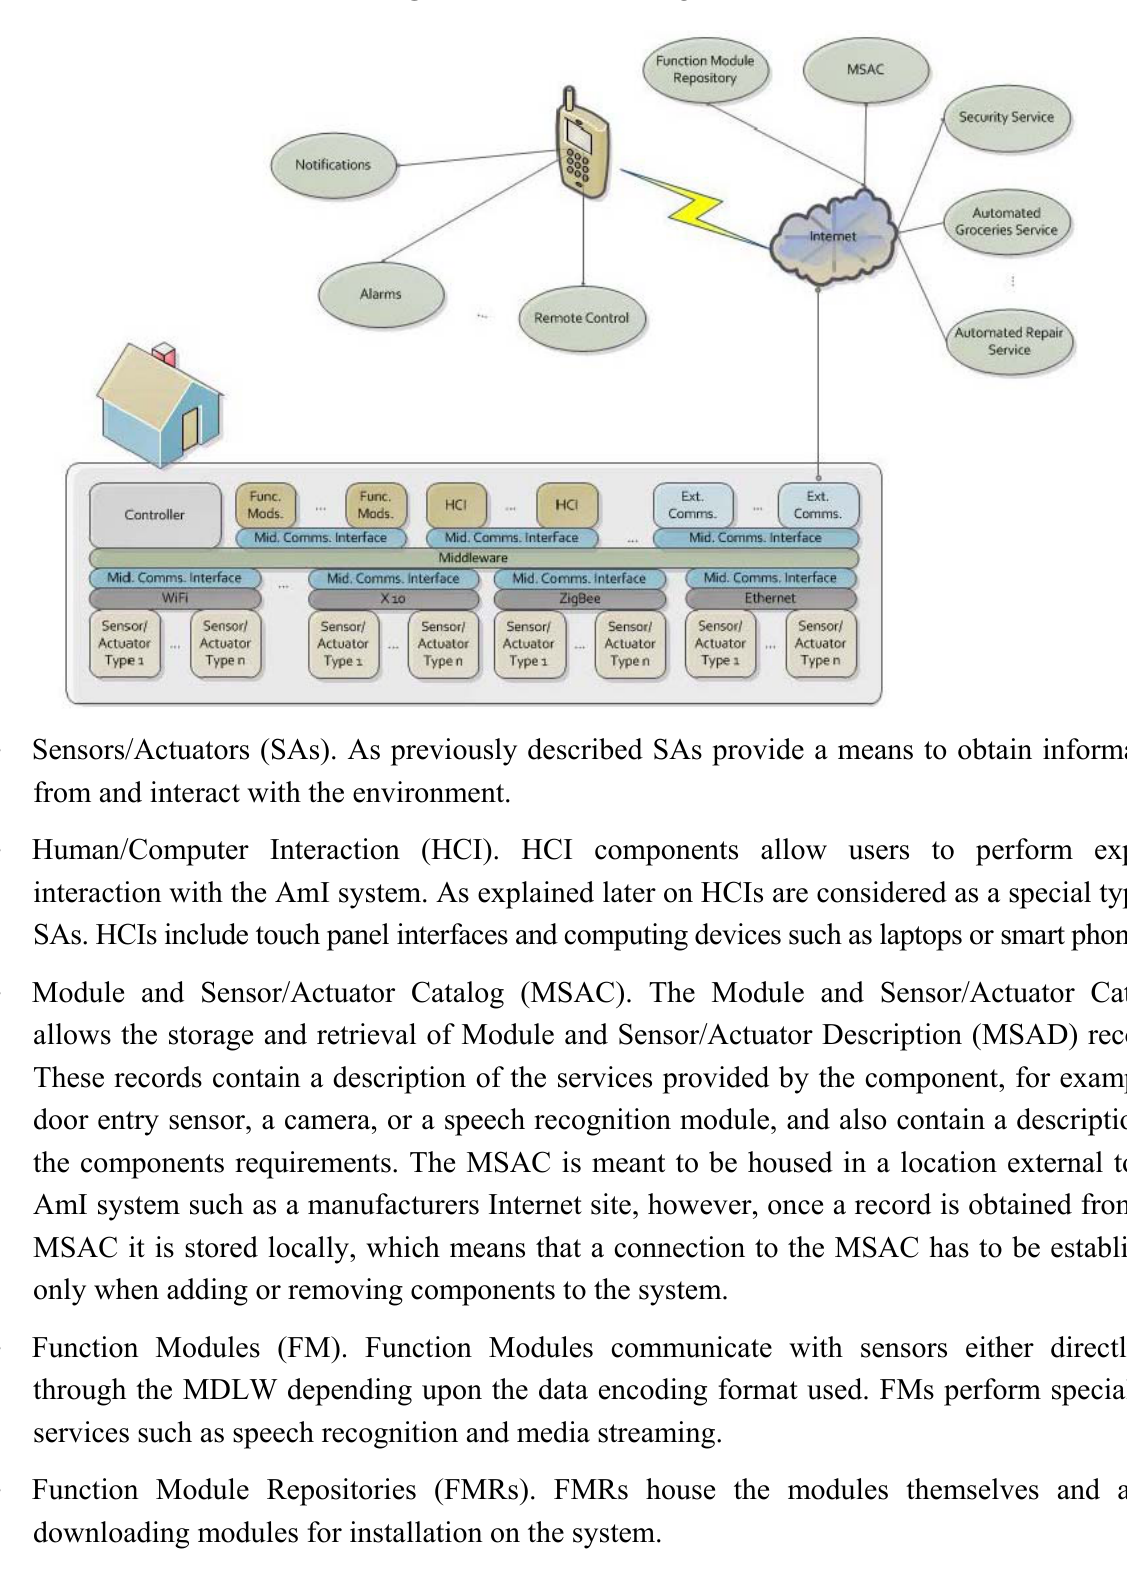
Figure 4. FunBlocks